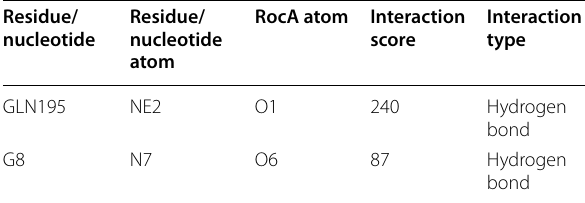
Table 1 Key interactions in the eIF4A1—RocA